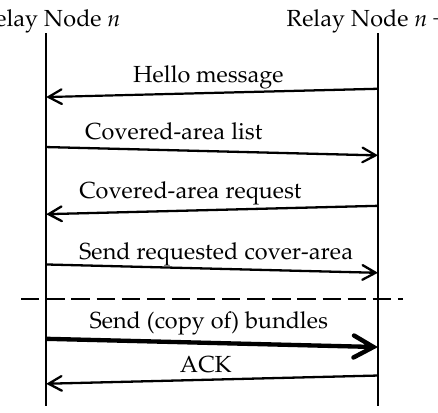
Figure 13. Procedure for relaying a bundle between relay nodes. Note: the bold arrow shows that a bundle copy is sent.